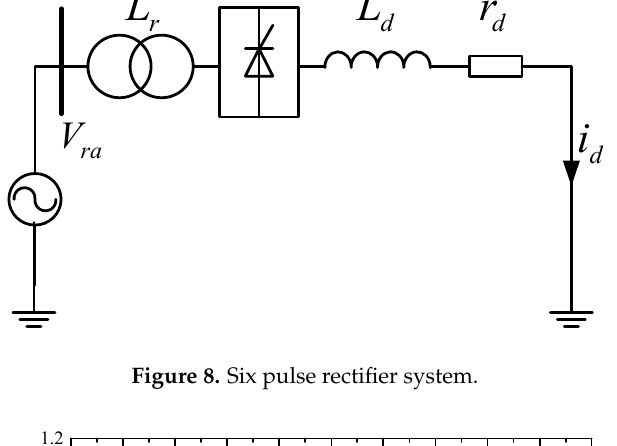
Figure 8. Six pulse rectifier system. Energies 2018 , 11 , x FOR PEER REVIEW